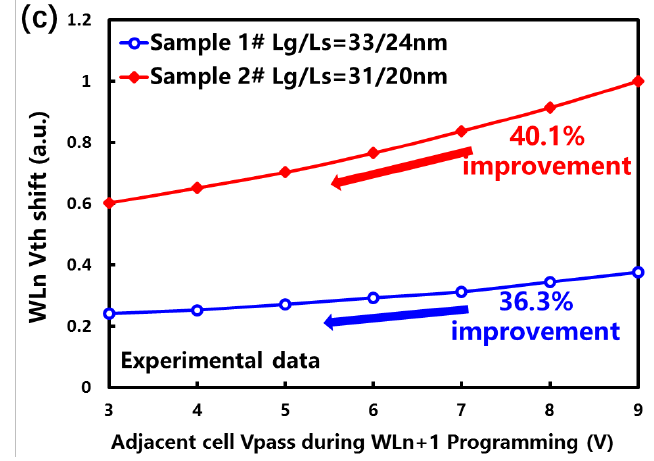
Figure 4. ( a ) Conventional and proposed scheme diagrams. ( b ) The simulation analysis of the proposed scheme. ( c ) The improvement of z-interference with the proposed scheme based on different Lg/Ls samples.